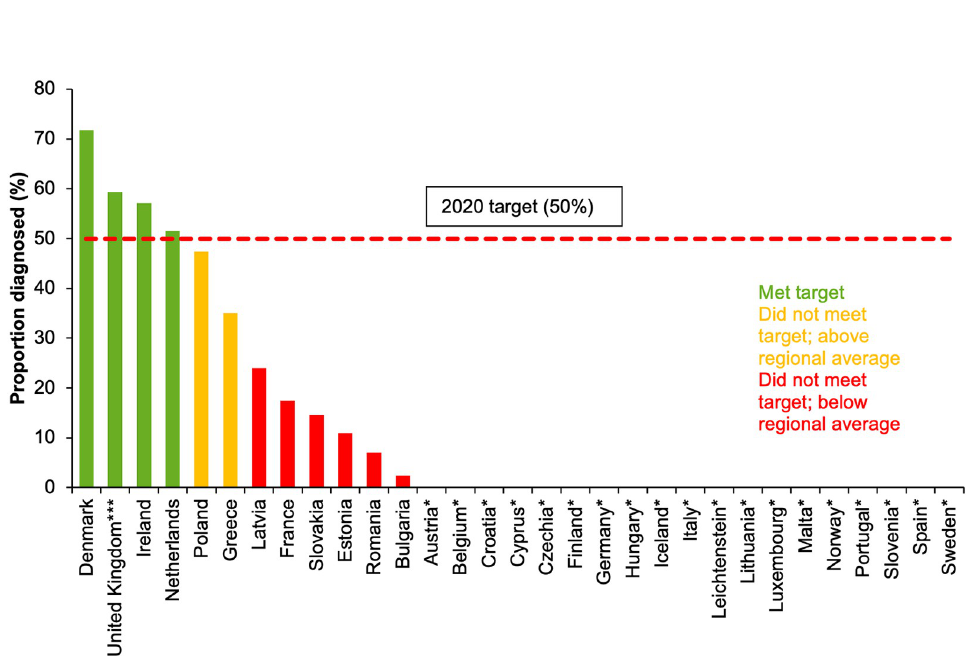
Fig 4. Proportion (%) of people living with chronic HBV infection who had been diagnosed in EU/EEA countries �� , 2017 � [8]. � No data from Austria, Belgium, Croatia, Cyprus, Czech Republic, Finland, Germany, Hungary, Iceland, Italy, Liechtenstein, Lithuania, Luxembourg, Malta, Norway, Portugal, Slovenia, Spain, Sweden. �� Data incomplete on diagnosed cases from Bulgaria (data from 2016), Estonia (data from 2004) and the Netherlands (data from 2000). ��� Data represent Scotland